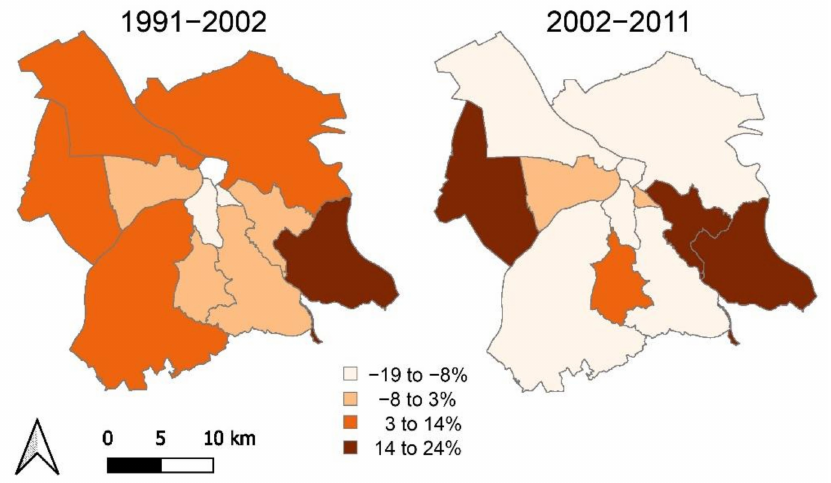
Figure 1. Administrative unit of Belgrade (dashed line) and study area defined by the General Urban Plan of Belgrade 2021 (solid line). Map credit: Google Maps, 2021.